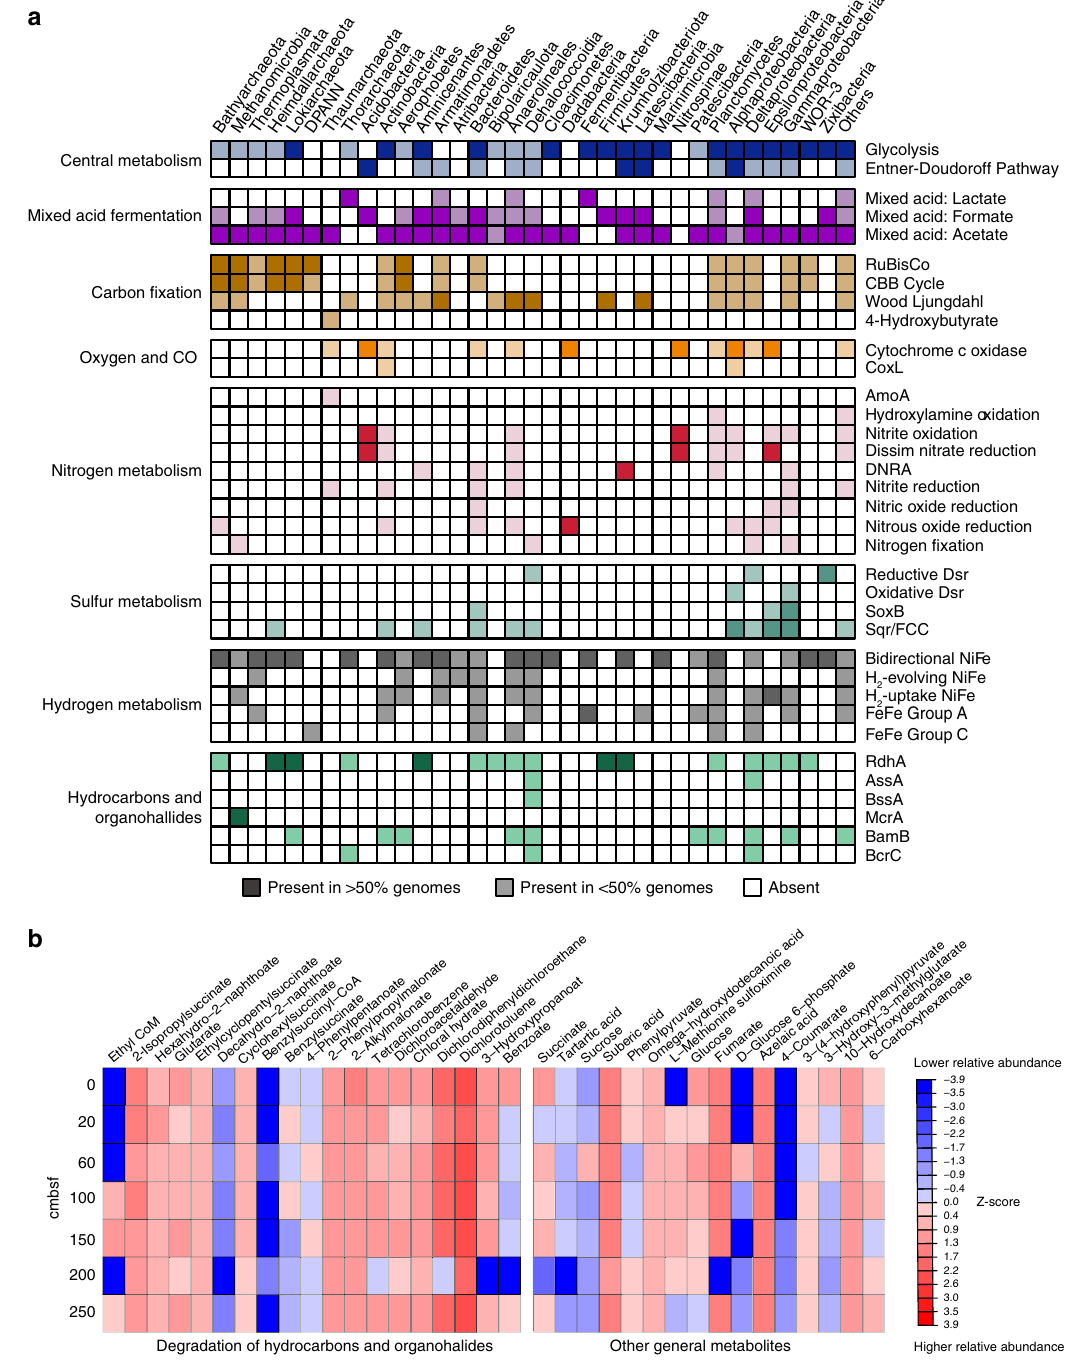
Fig. 3 Functional pro fi les of different microbial groups and metabolites identi fi ed at different depths. a Occurrence of core metabolic genes or pathways in phylogenetic clusters of MAGs. Phyla with only one representative MAG in the data set ( n = 10) and MAGs that could not be classi fi ed ( n = 10) are grouped together in the right-most column (Others). Dark and light color shading indicate gene presence in >50% and 1 – 50% of the genomes in each phylogenetic cluster, respectively. Complete lists of metabolic genes or pathways can be found in Supplementary Data 5. Detailed gene lists for each pathway indicated can be found at: https://github.com/bjtully/BioData/blob/master/KEGGDecoder/KOALA_de fi nitions.txt. b Metabolites identi fi ed in sediment porewater from down core sediment subsamples. Metabolite levels were measured using HPLC Orbitrap mass spectrometry and are expressed as cumulative sum logarithmically normalized peak areas of triplicates. Alkyl-/arylalkylsuccinates and ethyl-CoM are signature metabolites for anaerobic hydrocarbon degradation, whereas other compounds shown can be derived from multiple biological or abiotic